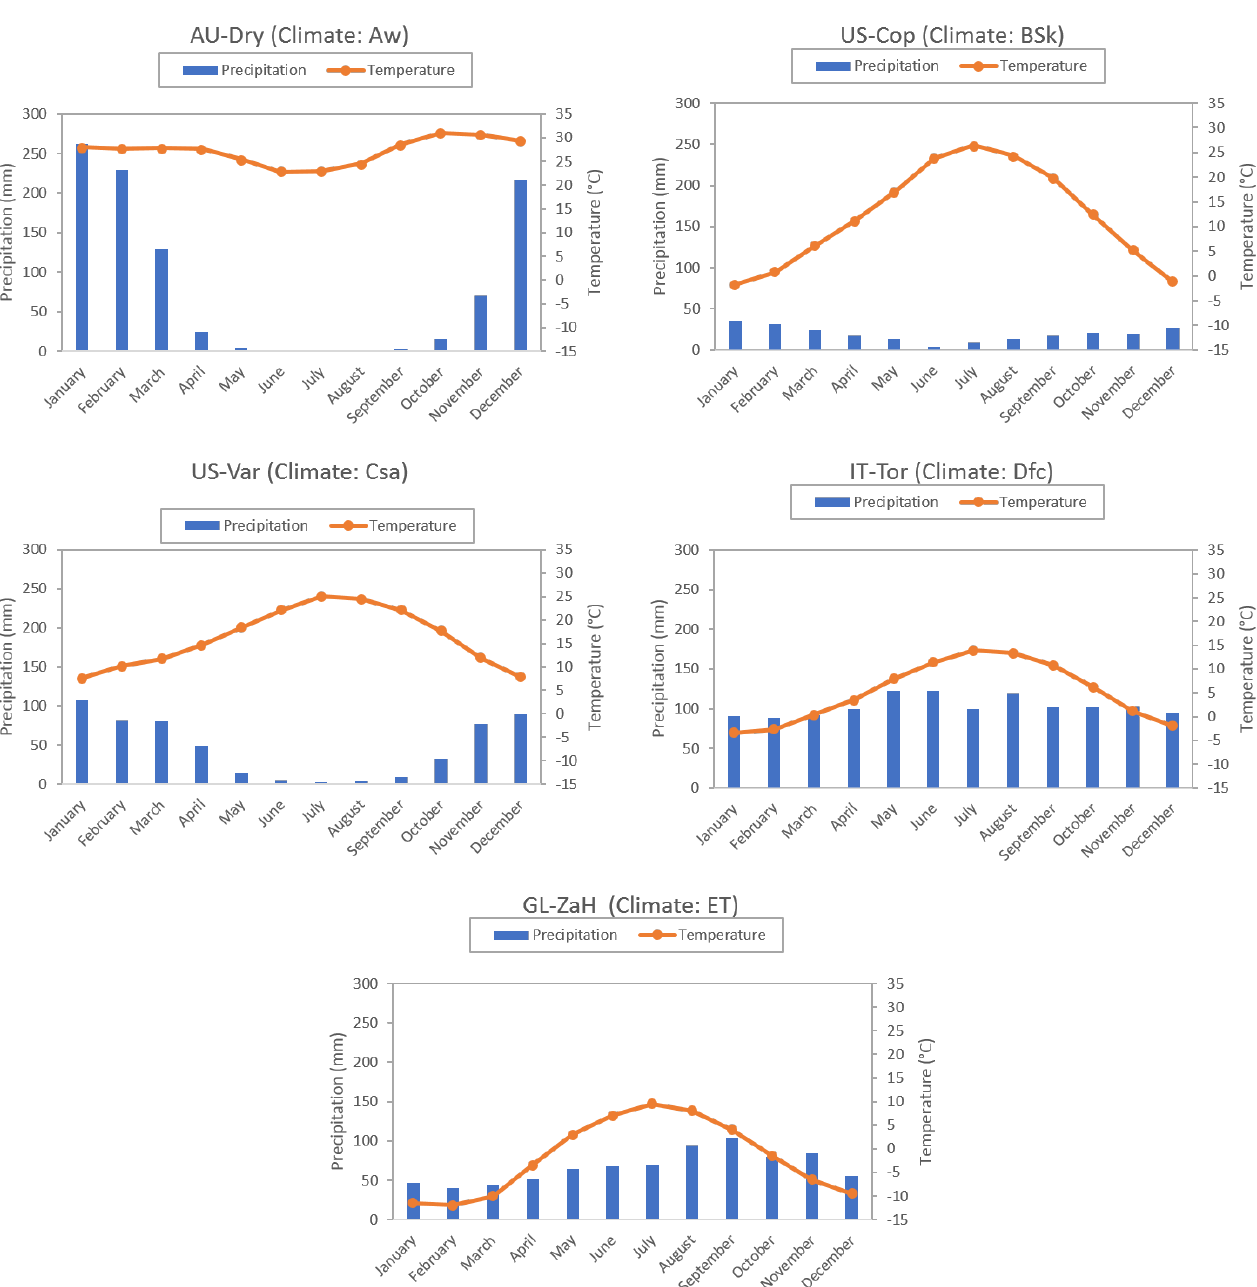
Figure 2. Monthly patterns of precipitation and air temperature for the five considered